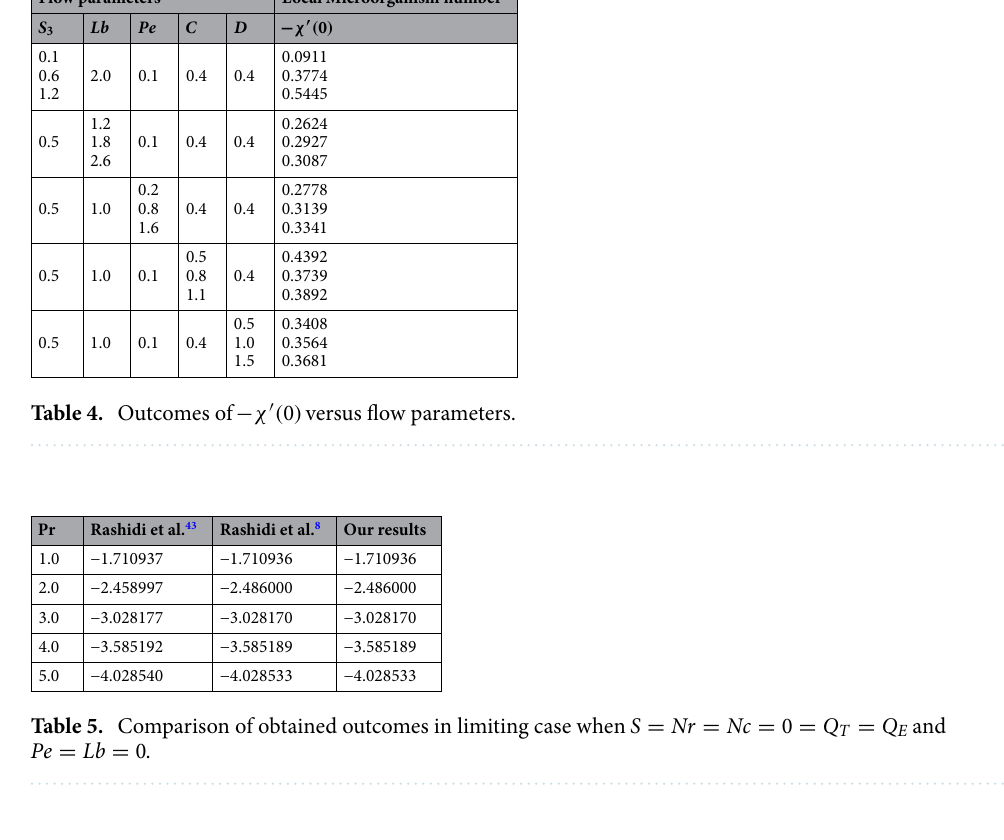
Table 5. Comparison of obtained outcomes in limiting case when S 0 Pe Lb = =